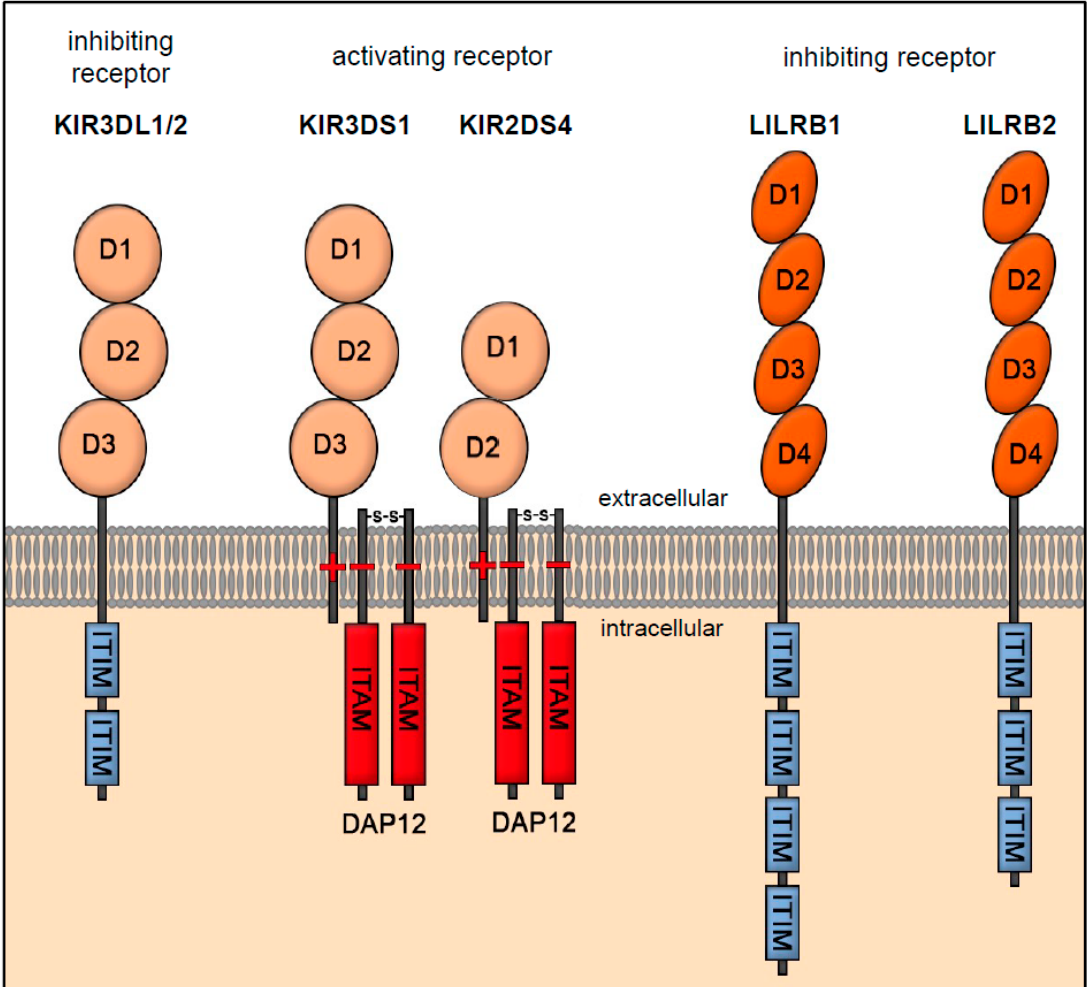
α 3 domain of the MHC Class I and recognize numerous HLA Ia and Ib molecules in addition to HLA-F.